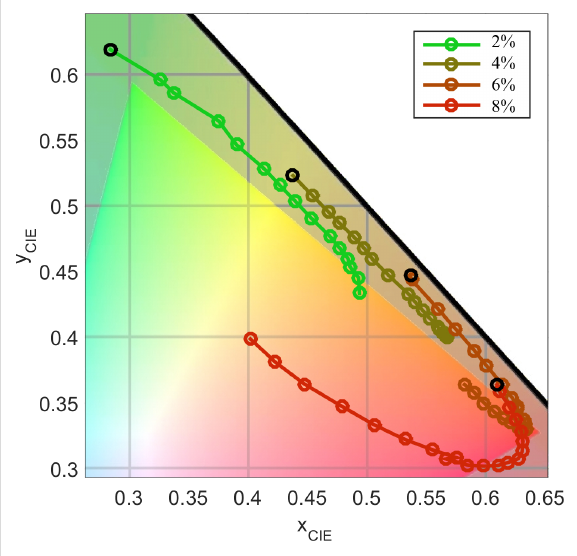
Figure 4: CIE values of the spectra of four different samples (2 to 8% TiO 2 ) for strain values of 0 to 20% perpendicular to their grating direc- tion. The measurements form lines parallel to the spectral locus from green to red (the black circle is the starting point with 0% strain for each